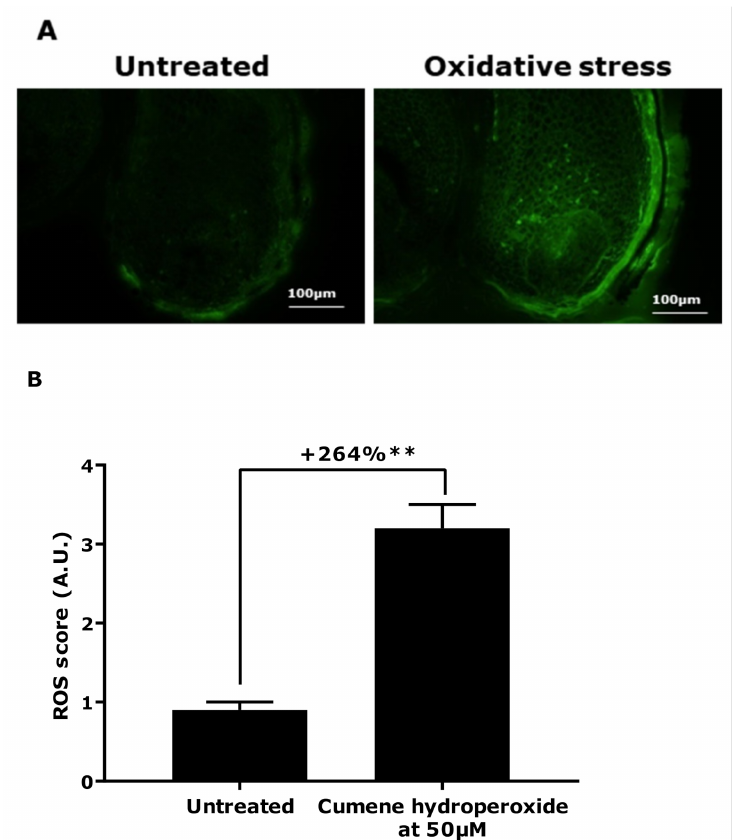
Figure 2. Reactive oxygen species (ROS) production assessment following oxidative stress (cumene hydroperoxide at 50 µ m) in hair follicles. ( A ) Representative images. Magnification: 20 × . ( B ) Quan- tification of the mean fluorescence intensity ( ± SEM) of dichlorofluoerescein diacetate (DCFH-DA) probe. Statistical analysis was performed using one-way ANOVA with a permutation test followed by Tukey’s test, with ** p <